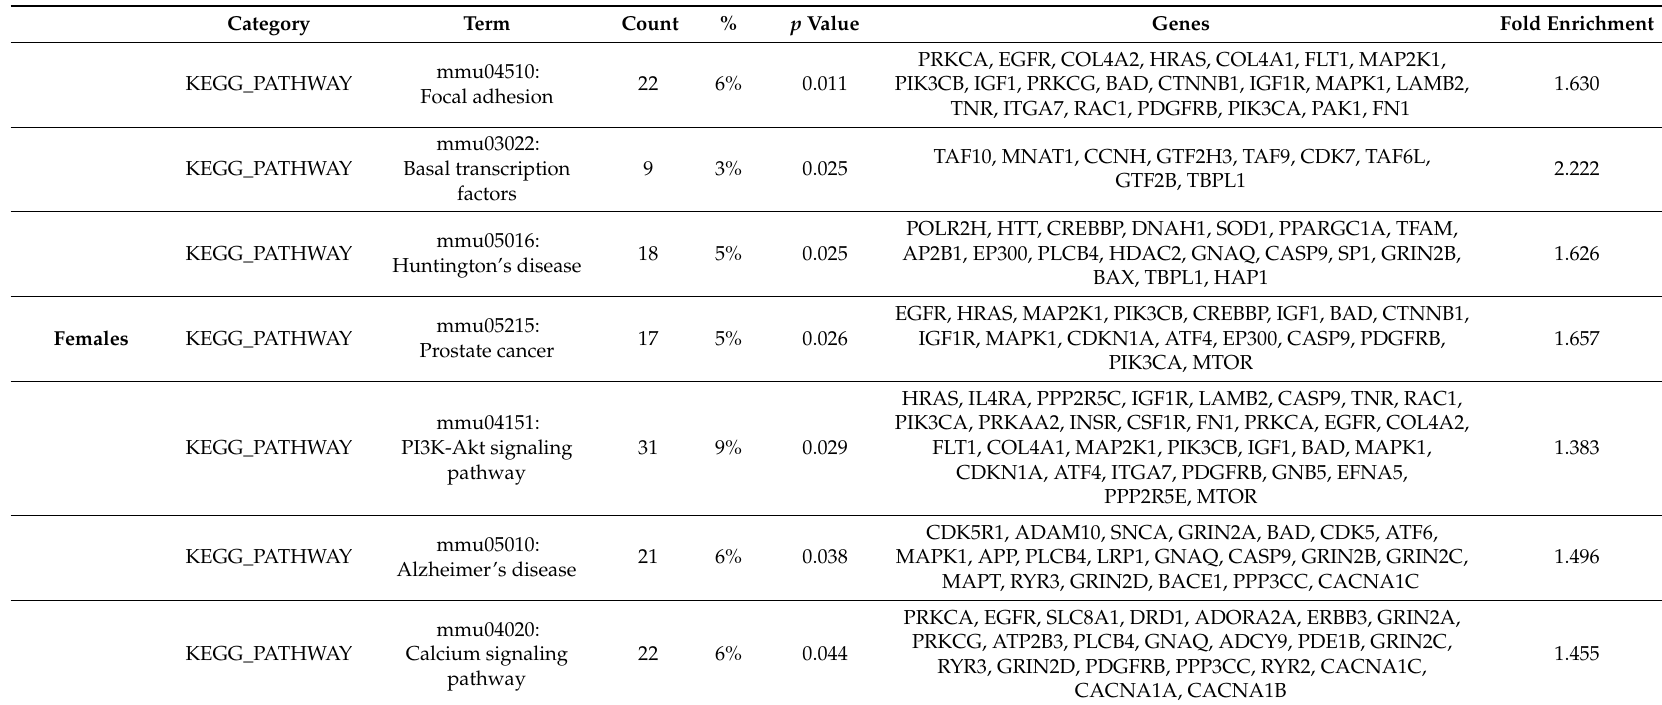
Table 1. Functional enrichment analysis of the genes significantly changed by VPA in females and